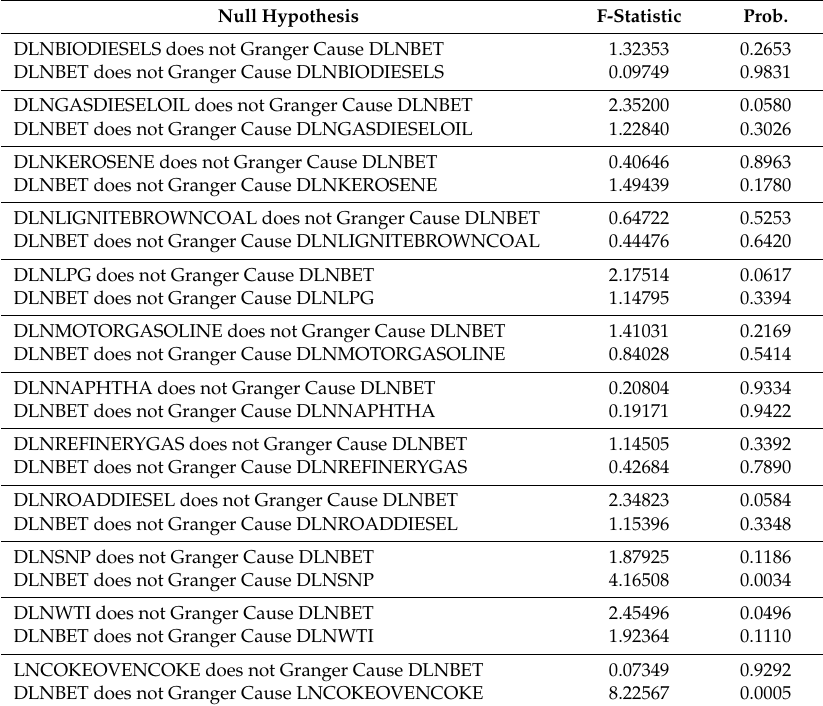
Table 10. The results of the Granger causality